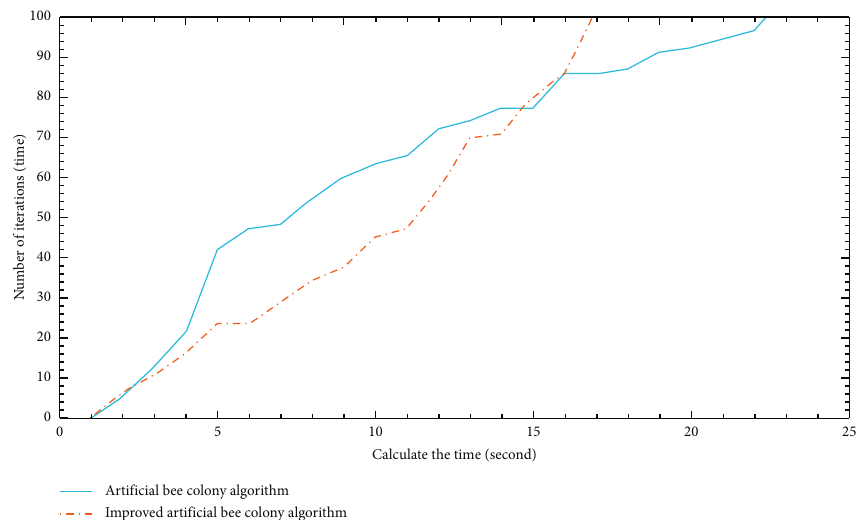
Figure 5: Comparison of calculation time of economic development forecast of sports